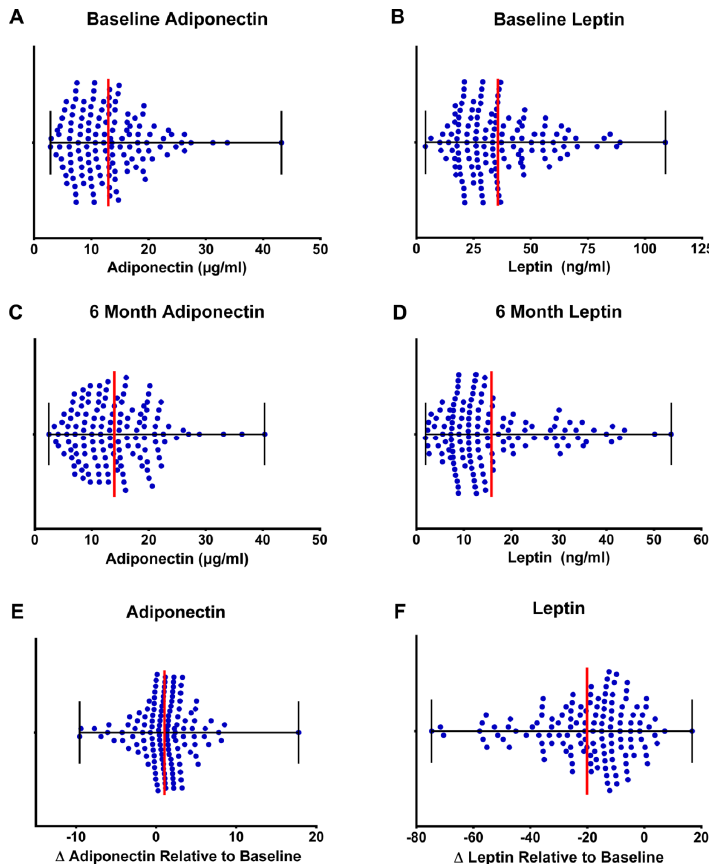
Figure 4. Distribution of plasma adipokines at baseline and end of study. ( a ) Scatterplot showing the mean and range for plasma adiponectin and leptin at baseline. The plasma concentration of adiponectin that is observed in normal weight individuals is 7–5 µg/mL. Greater than 50% of participants in CHOICE were within this range at